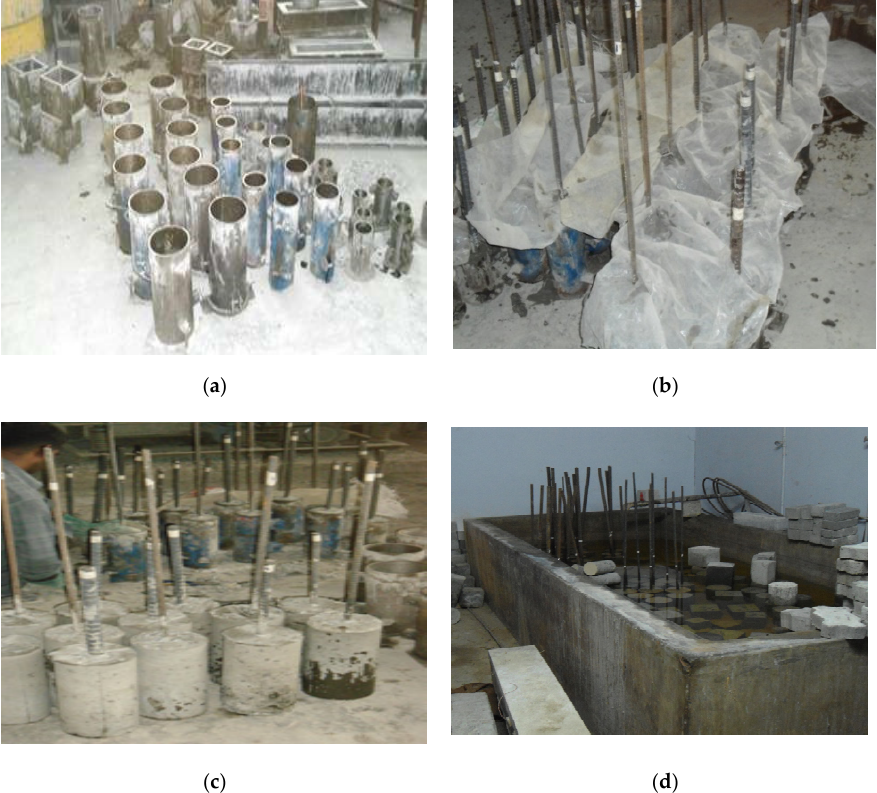
Figure 4. Casting–testing process: ( a ) Molds ready for casting; ( b ) Pullout samples after pouring; ( c ) Capped test samples after pouring; ( d ) Curing of test samples.